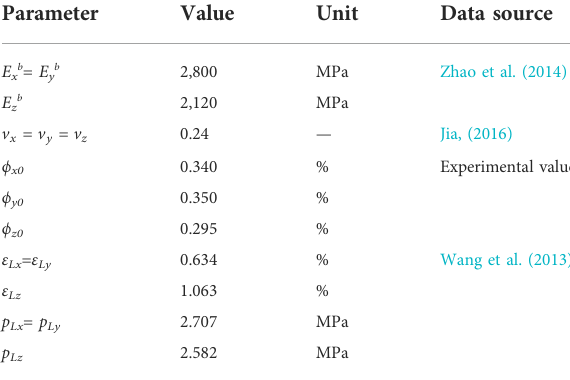
TABLE3Parametervaluesusedformodelvalidationofpermeabilityof cubic